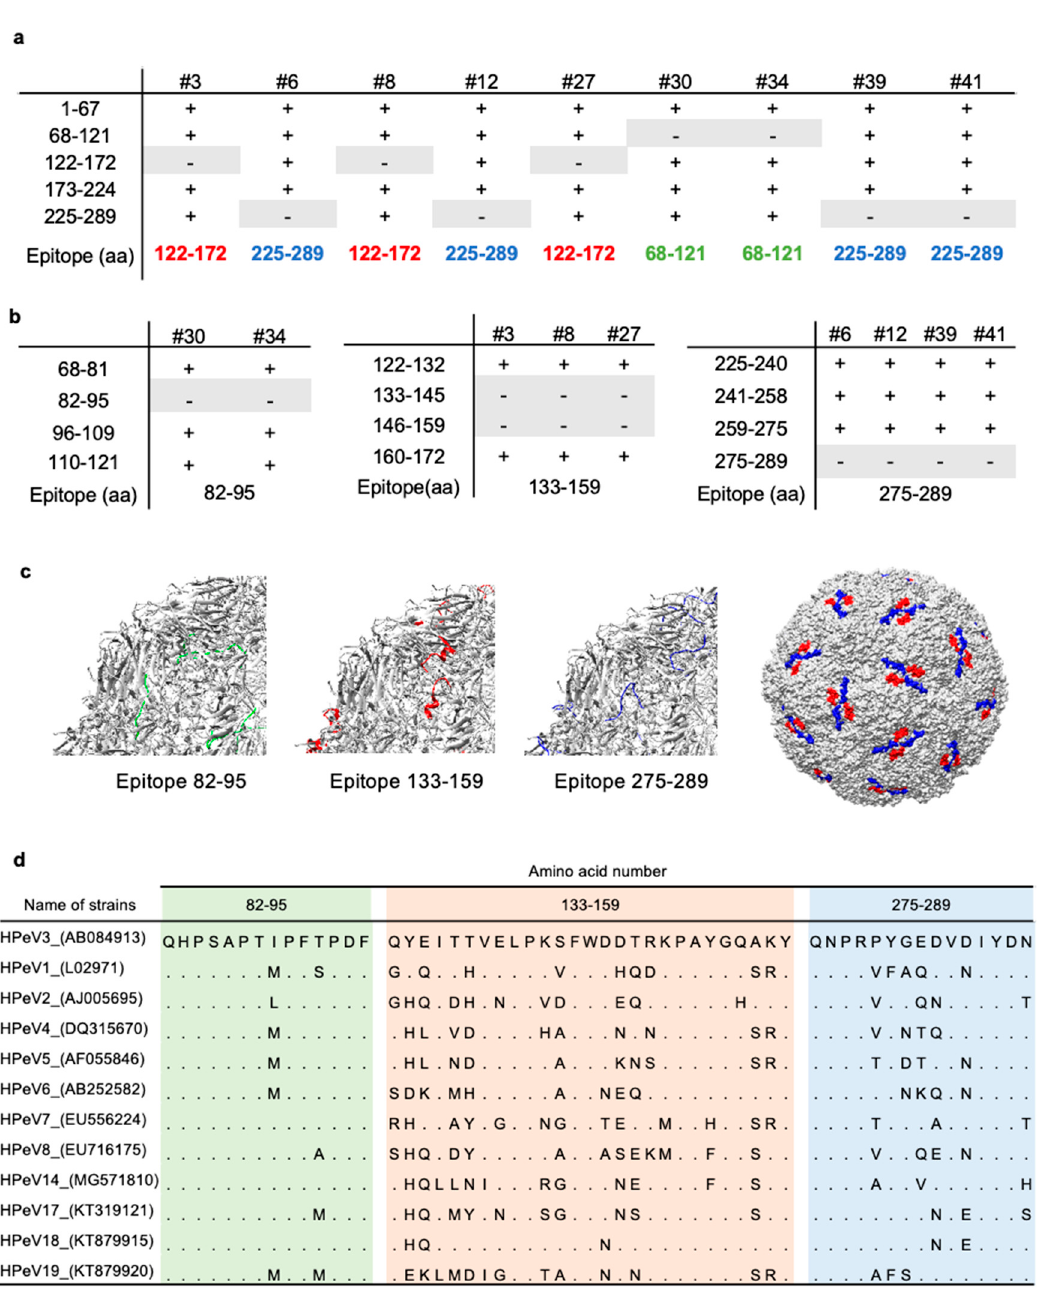
Figure 2. Epitope mapping of mAbs. ( a , b ) Deletion mutants of VP0 were produced by wheat germ cell-free protein synthesis. Reactivity of each mAb to the deletion mutants was evaluated by immunoblotting. + and – indicate positive and negative detection, respectively. ( c ) Position of epitopes in a structural model of HPeV3 VP0 (PDB ID. 6GV4). Epitope localizations of the various mAbs are highlighted in different colors. ( d ) Multiple alignment of sequences in HPeV VP0 proteins in the epitope region.